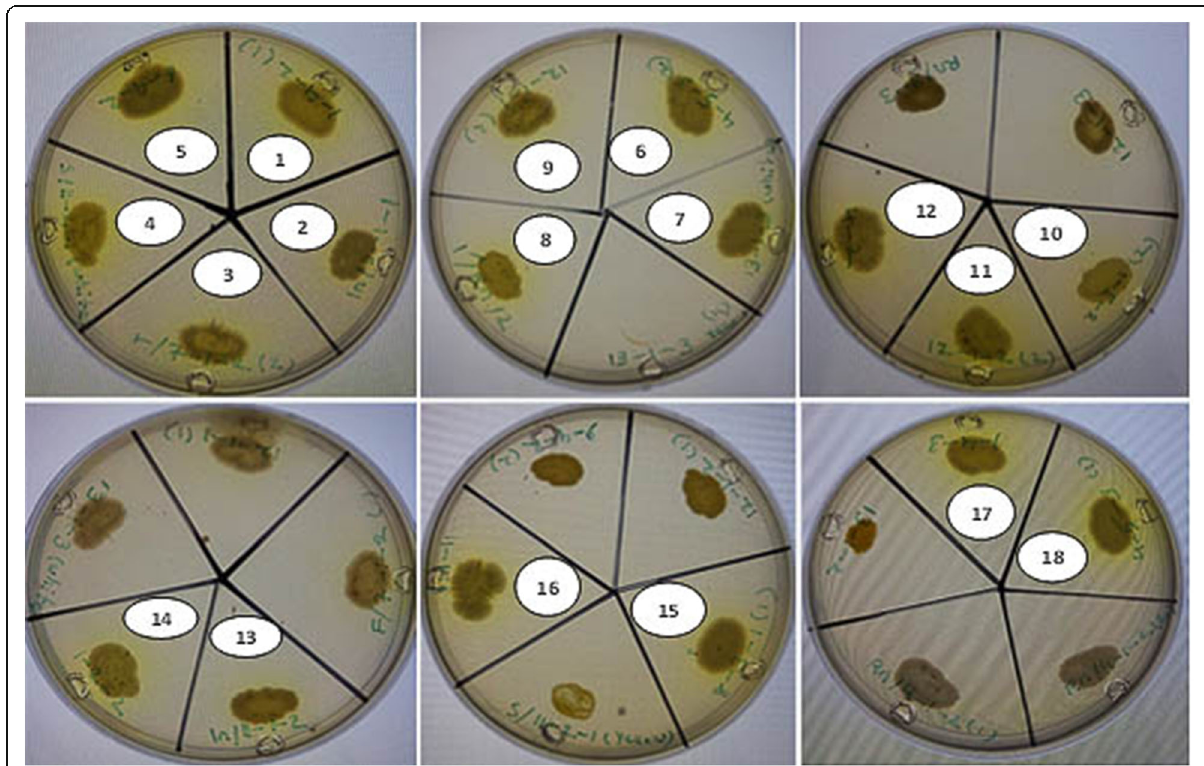
Fig. 3 Ability of the selected Pseudomonas isolates to produce siderophore. 1:9421, 2: LN1111, 3: F7122, 4: S1121W, 5: 642, 6: 4532, 7: 1313W, 8: 1RN2, 9: 12112, 10: 8312, 11: 12122, 12: 42, 13: LN1112, 14: 122, 15: 8311, 16: 1111, 17: 943, 18: 4531